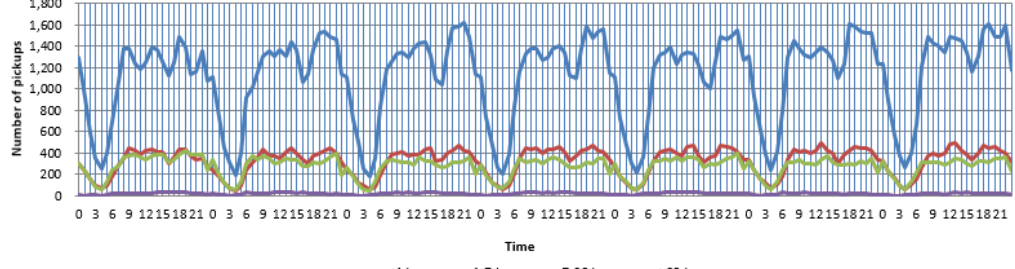
Figure 5. Temporal variations of PUP with different distances.